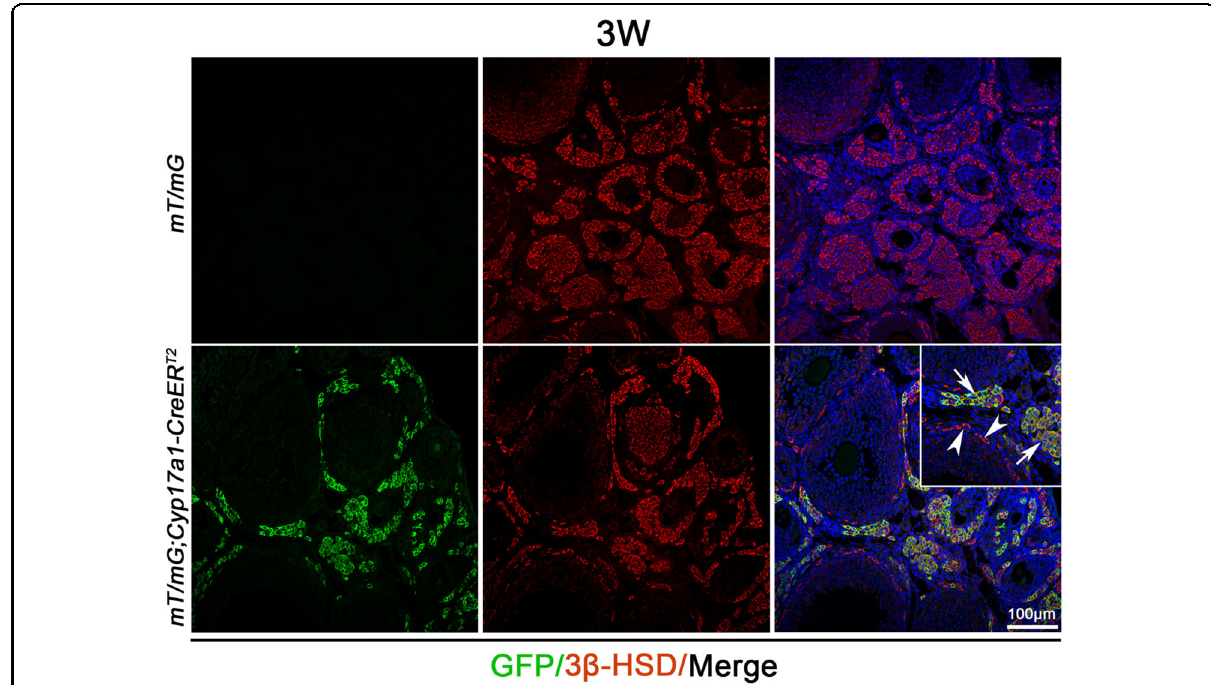
Fig. 4 GFP signal was detected in the theca-interstitial cells of mT/mG; Cyp17a1-CreER T2 mice. Cre activity in mT/mG; Cyp17a1-CreER T2 was induced with tamoxifen at 3 weeks of age and GFP signal was examined by immunostaining. 3 β -HSD signal was detected in both Theca-G (inset, white arrowheads) and Theca-S (inset, white arrows) and no GFP signal was detected in the ovaries of control mice after tamoxifen induction (top